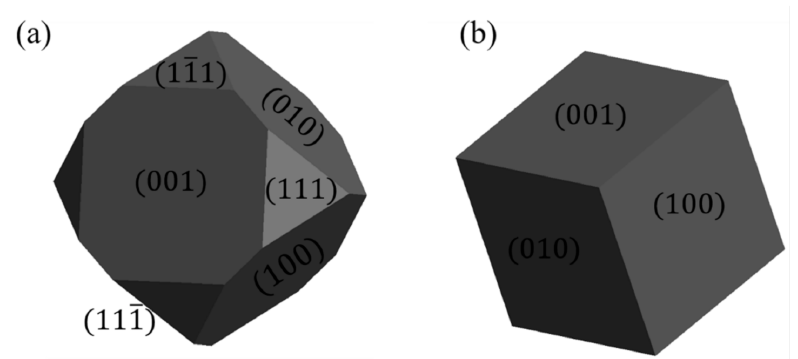
Figure 4. Wulff plots of the equilibrium morphologies of ( a ) the dry nanoparticle and ( b ) the hydroxylated nanoparticle of Fe 2 CoO 4